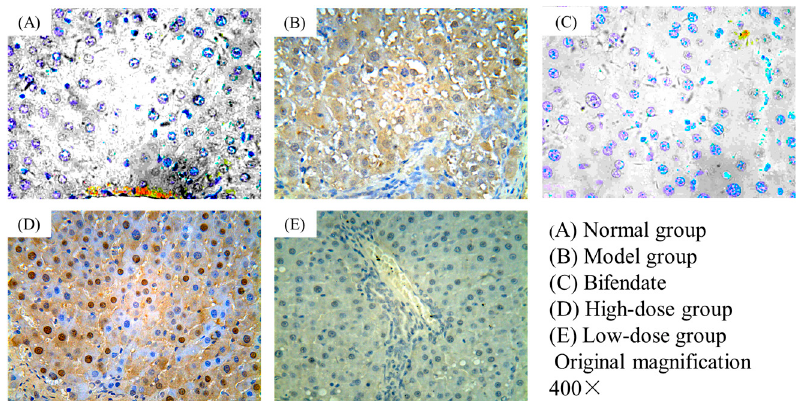
Figure 3. Immunohistochemical staining showed the expression of transforming growth factor β 1 (TGF- β 1). ( A ) Normal group, showed no expression of TGF- β 1; ( B ) Model group, showed a high expression of TGF- β 1; ( C ) Bifendate (10.5 mg/kg), showed a low expression of TGF- β 1; ( D ) High-dose group (Oxy-Di-OA, 28 mg/kg), showed a lower expression of TGF- β 1 compared to model group; ( E ) Low-dose group (Oxy-Di-OA, 14 mg/kg), showed a lower expression of TGF- β 1 compared to model group.